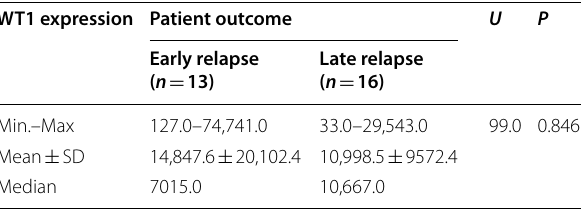
Table 8 Relation between patient outcome and WT1 expression in relapsed AML patients ( n